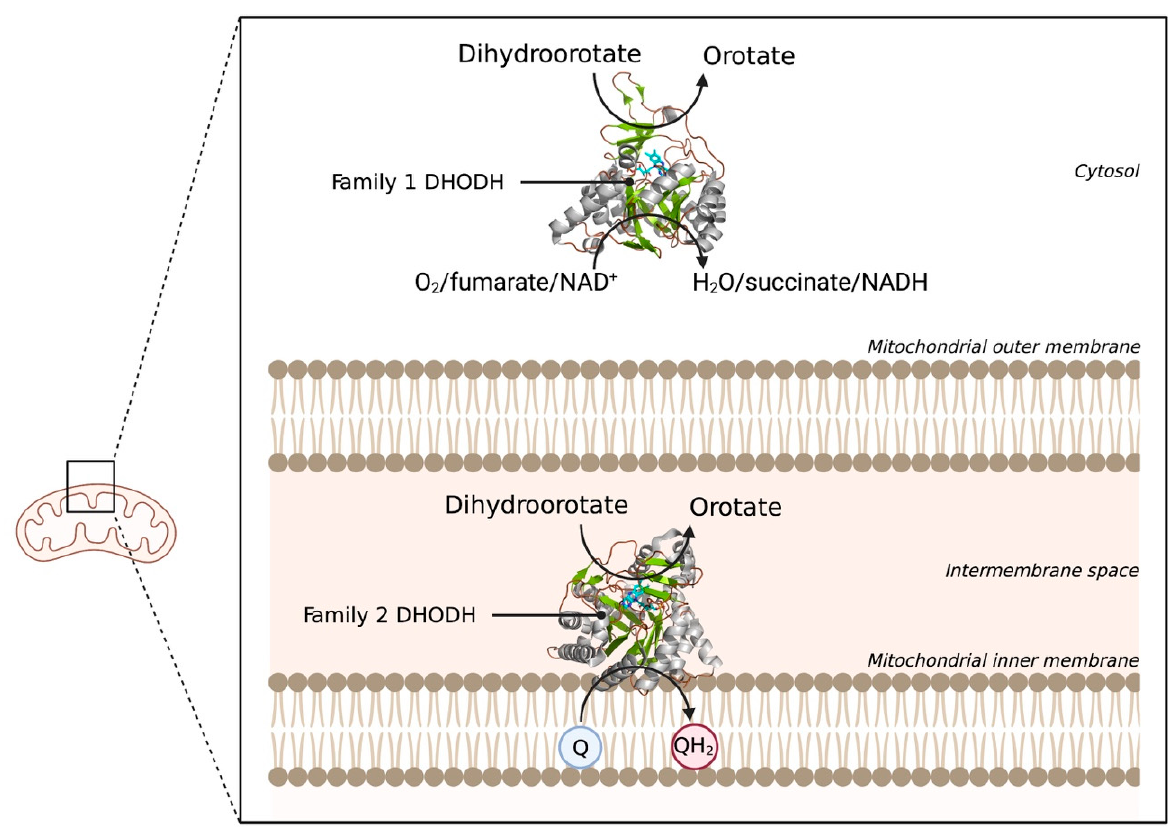
Figure 7. Schematic overview of the locations and reactions of both DHODH families. The two DHODH families are visualized with their respective location in the cell. Family 1 DHODH uses O 2 , fumarate, or NAD + as electron acceptors. Family 2 uses ubiquinone (Q) as an electron acceptor, which gets reduced to QH 2 . 3D structural cartoons showing the Family 1 DHODH from Trypanosoma brucei (PDB:5XFV) [106], and the Family 2 DHODH from Plasmodium falciparum (PDB:6VTN) [107] were rendered with PyMol and the figure compiled using BioRender.com [8].